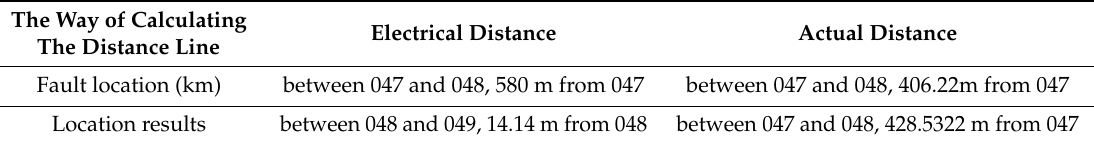
Figure 11. The line-mode traveling wave waveform in the actual distance model. Table 3. Comparison of fault location results from the electrical and actual distance models.